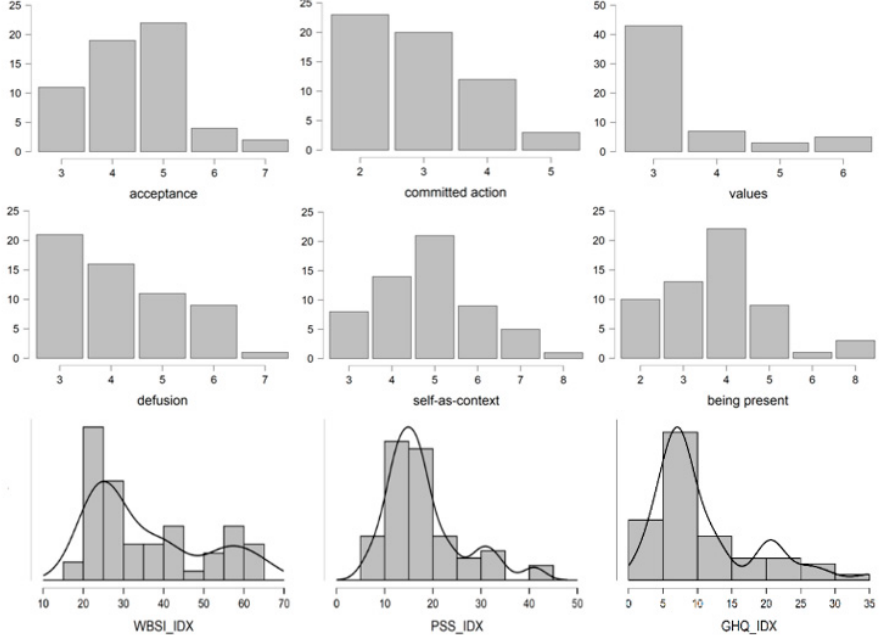
Figure 3. Distribution of the total scores of WBSI, PSS, GHQ and the subscales of 6-PAQ for group 1 (low